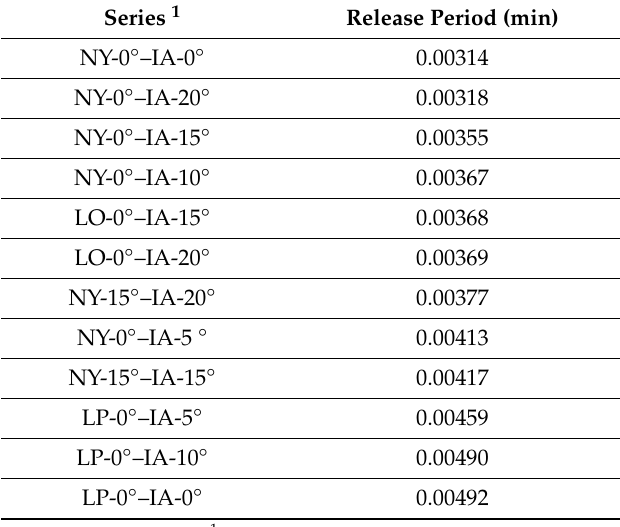
Table 4. Release periods in ascending order.